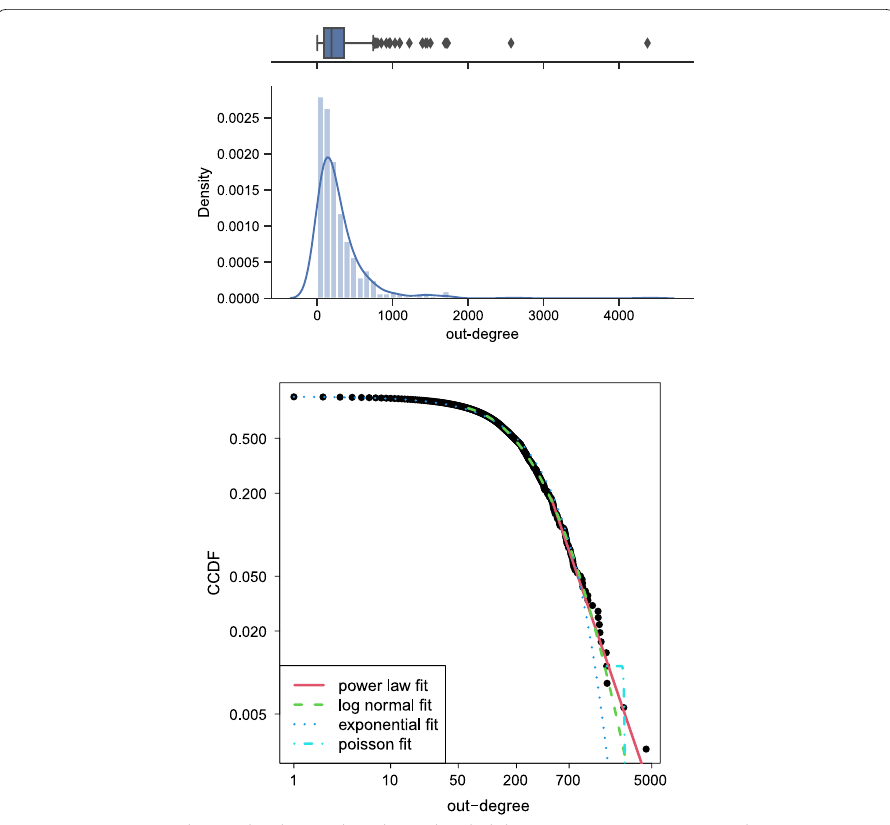
Fig. 10 I nstancEs out-degree distribution: boxplot and Probability Density Function (top), and Complementary Cumulative Distribution Function, with various distribution fittings